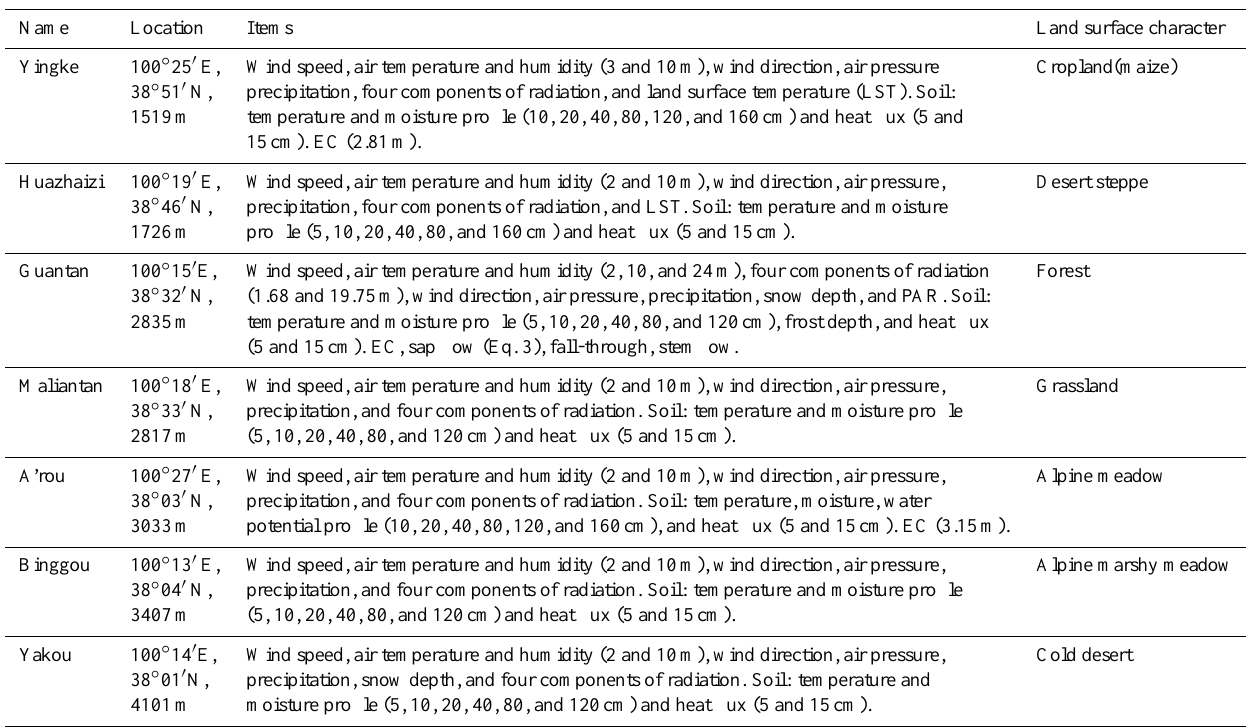
Table 1. Ground measurement items in the WATER